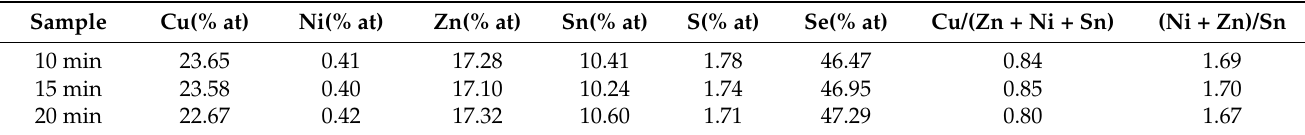
Table 1. EDS results of the CNZTSSe films at selenidation times of 10 min, 15 min, and 20 min.